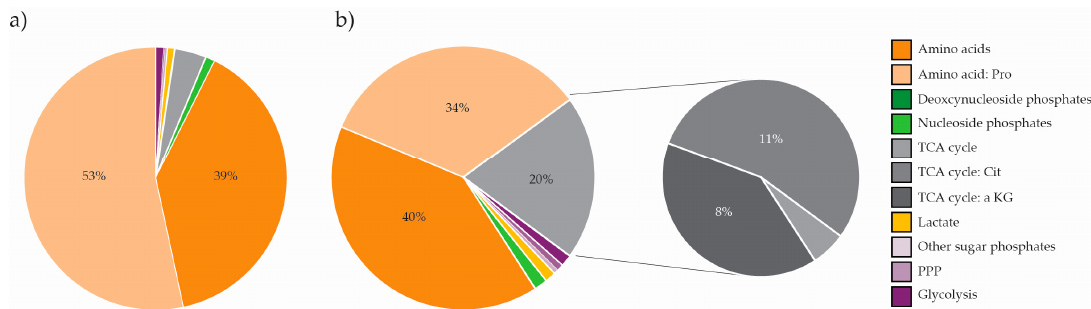
Figure 5. Contribution (%) of metabolite classes to the total measured level of metabolites in microalgae ( a ) Nannochloropsis oceanica and ( b ) Phaeodactylum tricornutum, including the contribution of TCA cycle intermediates to the total measured TCA cycle level in P. tricornutum . Contributions > 4% are indicated with numbers. TCA, tricarboxylic acid; PPP, pentose phosphate pathway; Pro, proline; Cit, citrate; aKG, α -ketoglutaric acid.